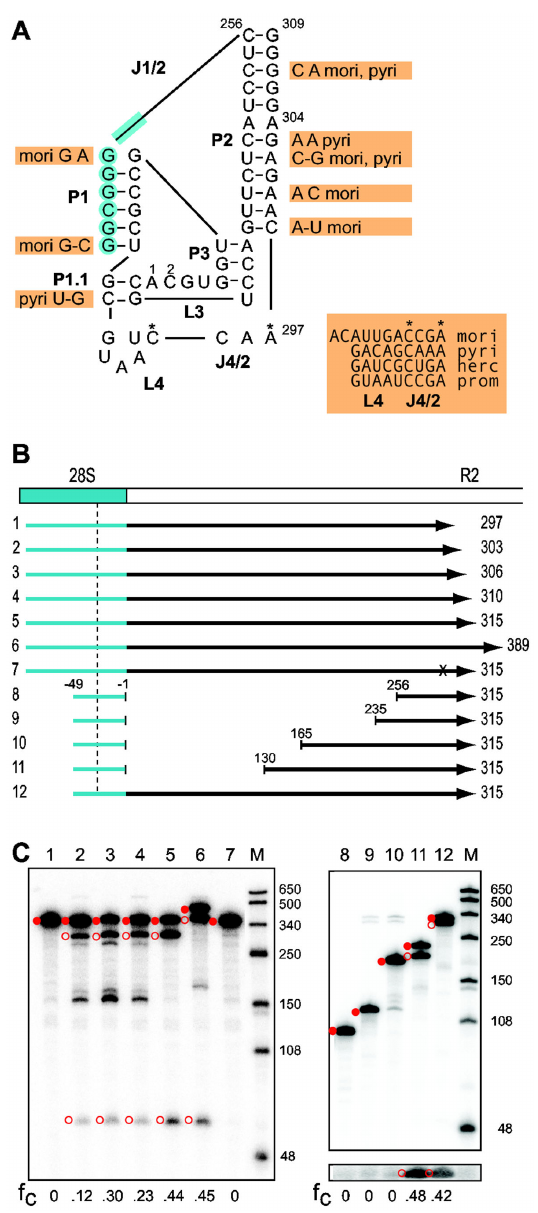
Figure 4. Comparison of the R2 ribozyme from 5 silkmoth species. (A) Secondary structure of the putative ribozyme encoded by the R2 element of S. cynthia . Blue shading indicates nucleotides from the 28S gene. Indicated next to the S. cynthia sequence are differences in the R2 sequences from 4 silkmoth species (nucleotides in orange boxes). The entire sequence of the largely unconserved L4- J4/2 region is presented for each species. Two species contained nucleotide differences in the otherwise conserved L3 (residue 1 is a 'U' in S. pyri , residue 2 is an 'A' in C. hercules ). The J1/2 loop length varied from 216 nt in S. pyri to 498 nt in C. hercules mori , B. mori ; herc, C. hercules ; prom, C. promethea ; pyri , S. pyri . (B) Diagrams of the 28S/R2 RNAs from S. cynthia tested for self-cleavage as described in Figure 2. The vertical dashed line indicates the predicted upstream cleavage site at -28. Negative numbers indicate position in the 28S gene relative to the R2 insertion site; positive numbers indicate position in the S. cynthia R2. The x in RNA 7 represents a 'U' substitution for the putative catalytic 'C'. Templates 8-11 have varying amounts of the J1/2 loop removed. (C) 5% denaturing acrylamide gels showing the products from the co-transcription/self-cleavage assays. Lane numbers correspond to the RNAs in panel (B). The uncleaved RNA (solid red circle) and self-cleavage products (open red circles) are indicated. Lane M, RNA length markers with sizes indicated. For RNAs 8-12, a longer exposure of the lower portion of the gel is shown to better visualize the 21 nt upstream cleavage products. The fraction of the synthesized RNA undergoing self-cleavage (fc) is shown at the bottom of each gel. doi: 10.1371/journal.pone.0066441.g004 PLOS ONE | www.plosone.org